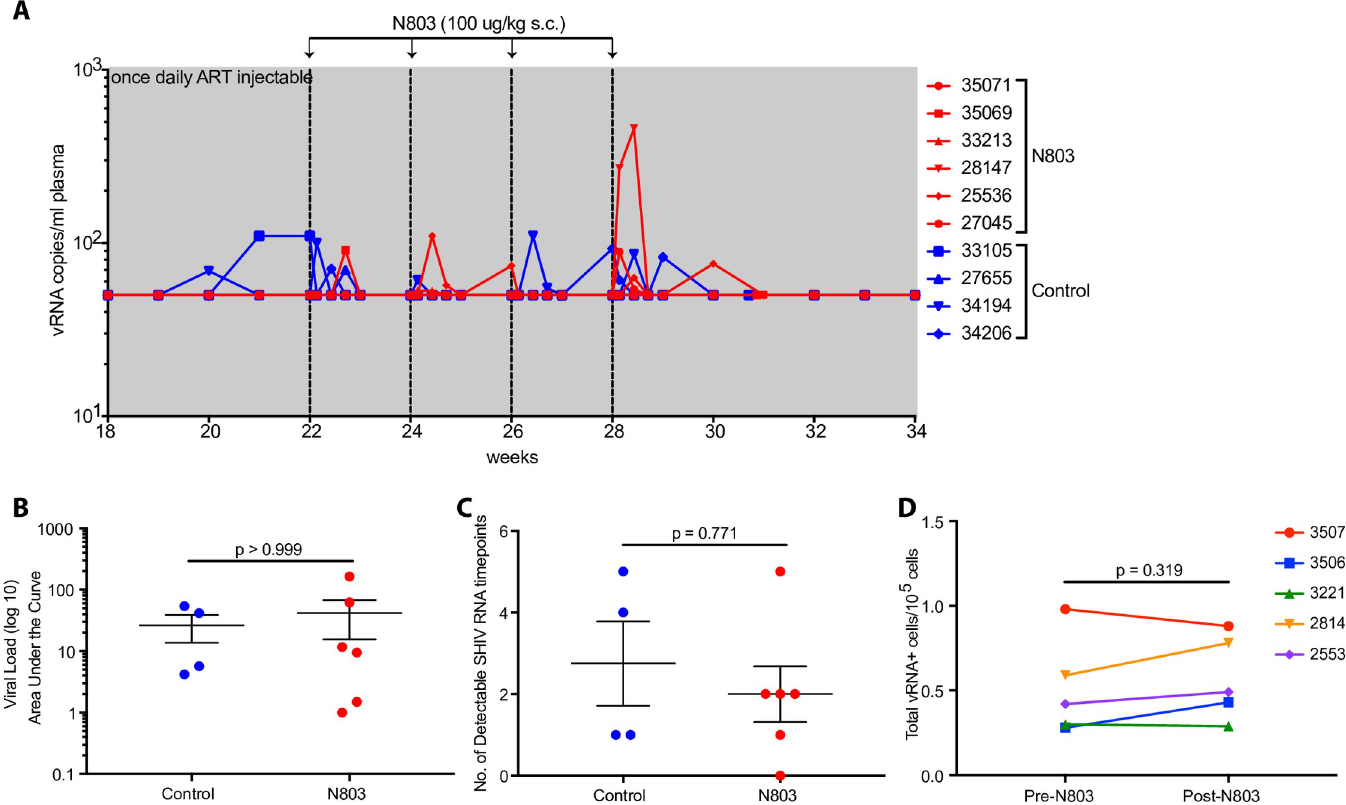
Fig 8. N-803 does not reverse latency in vivo . (A) Plasma viral loads shown during N-803 administration. N-803 was administered subcutaneously at a dose of 100 μ g/kg every other week, indicated by the vertical dashed lines. Horizontal dotted line indicates limit of detection (LOD) at 50 RNA copies/mL. (B) Area under the curve analysis of viral loads between groups between weeks 22–35. (C) Number of detectable SHIV RNA timepoints between groups. (D) Quantification of RNAscope in situ hybridization in axillary lymph nodes before, 5 days after N-803 and 7 days after N-803. Shown as SHIV RNA+ cells per 100,000 cells. P values were calculated using Mann-Whitney test (B, C) and a paired t-test (D) . � , P < 0.05; �� , P < 0.01; ��� , P < 0.001.